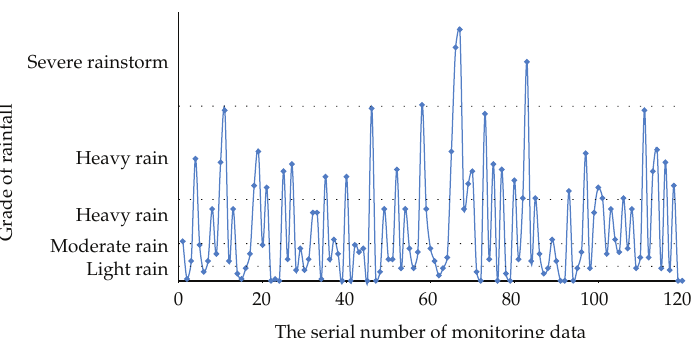
Figure 8: Rainfall distribution map.